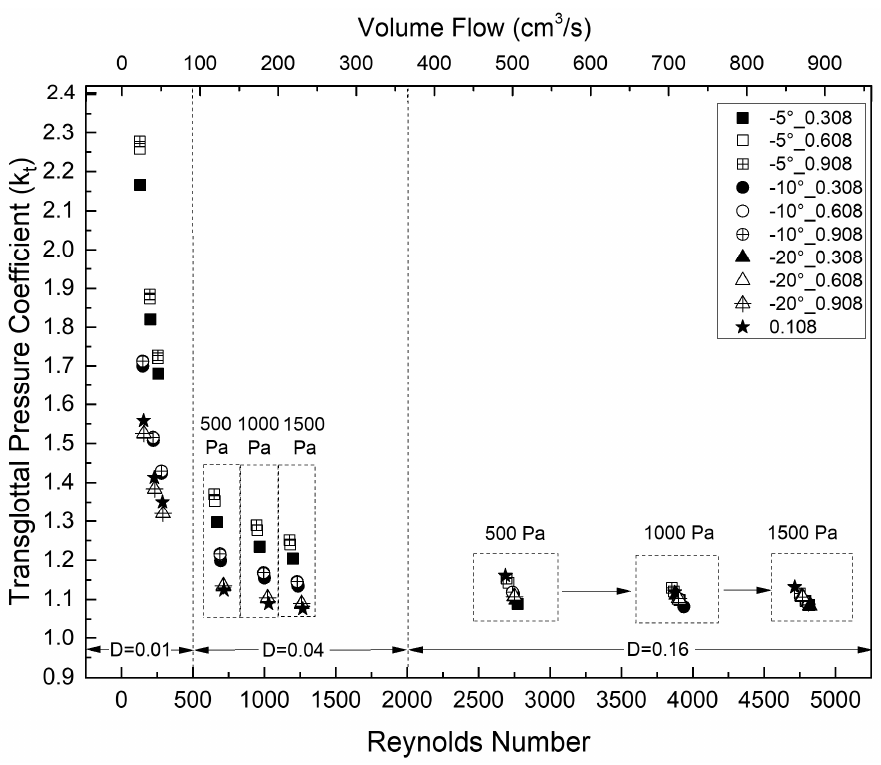
Figure 7. (Color online) Glottal volume flow as a function of the ratio of minimal glottal diameter to the vertical glottal duct length ( a ) for 0.108cm, 0.308cm, 0.608 cm, and 0.908 cm vertical glottal duct length, 500 Pa, 1000 Pa, and 1500 Pa transglottal pressure for − 5°convergent glottal angle; ( b ) for − 5°, − 10°, and − 20° convergent glottal angles for 500 Pa, 1000 Pa, and 1500 Pa transglottal pressures only for 0.308 glottal duct length cases.